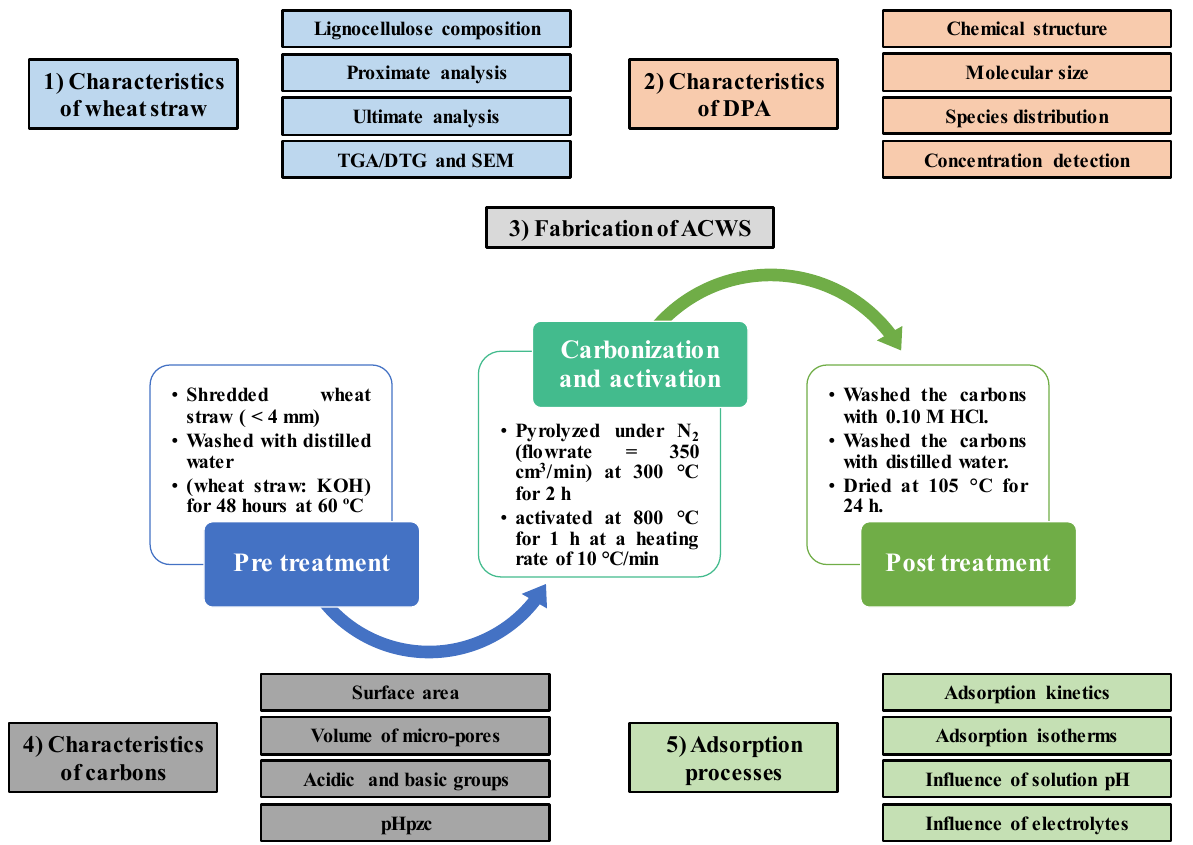
Figure 1. Research methodology for the preparation of carbon and the adsorption of DPA onto activated carbon.